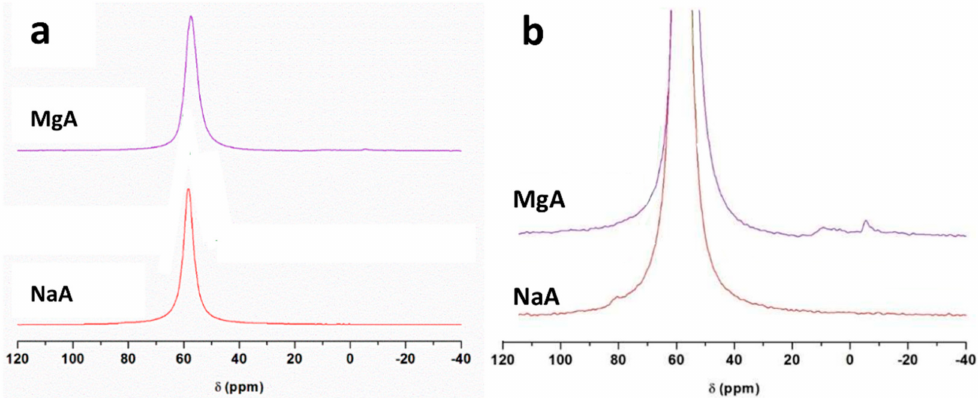
Figure 4. 27 Al MAS NMR spectra of ( a ) NaA and MgA powder samples and ( b ) a zoom of ( a ). Only the isotropic region is